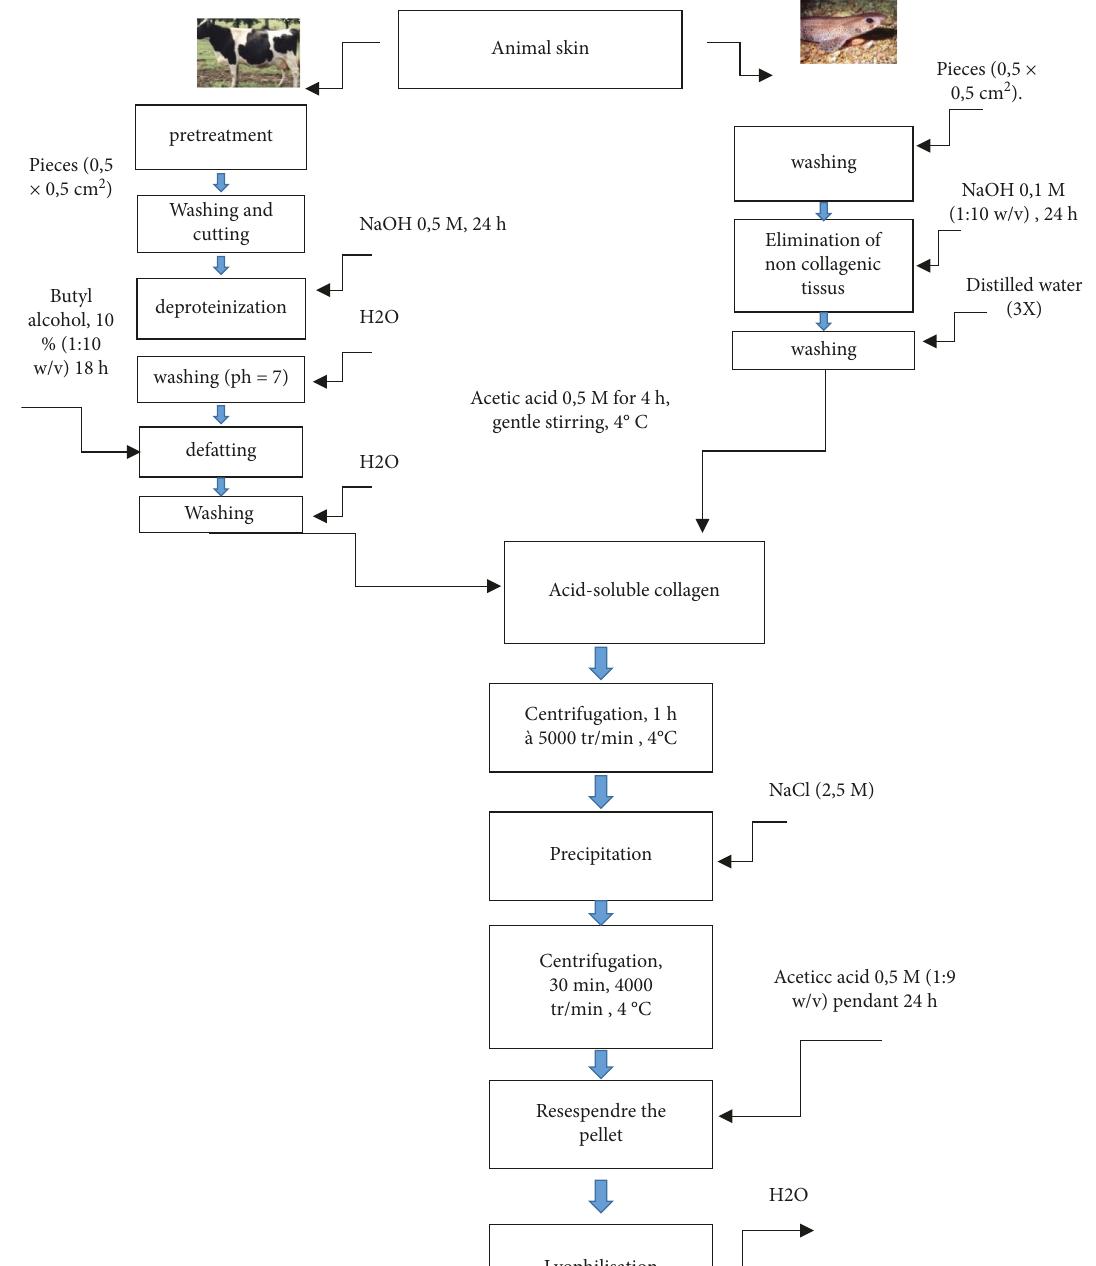
Figure 1: Flow sheet of the procedure used to extract collagen from two origins: Fish and bovine